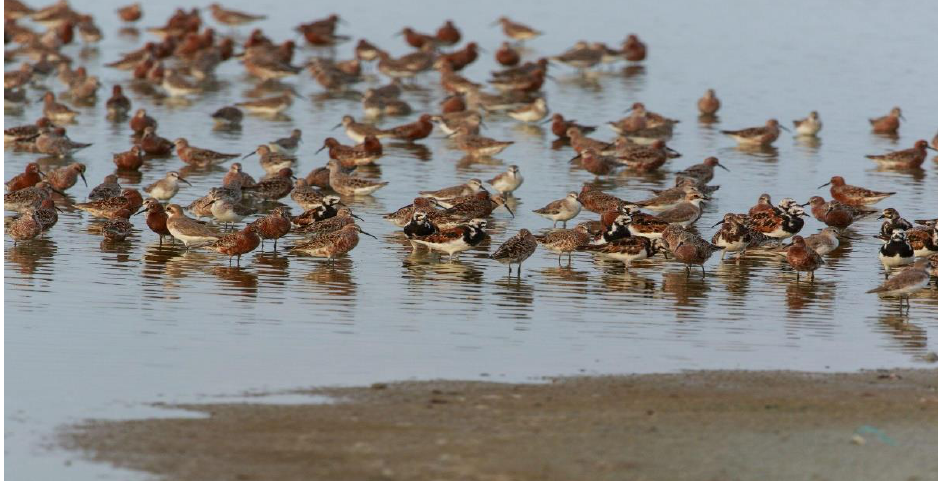
Figure 4. Mixed flock of Curlew Sandpiper ( C. ferruginea ) , Lesser Sand Plover ( C. mongolus ) , Greater Sand Plover ( C. leschenaultia ) and Ruddy Turnstone ( A. interpres ) observed at Gulf of Mannar at the east coast of India — Photo courtesy H. Byju.